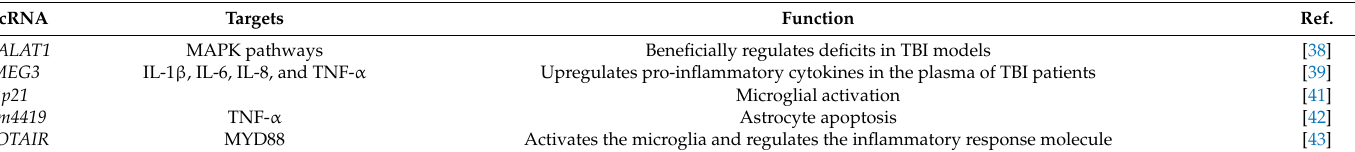
Table 1. A list of lncRNAs in brain